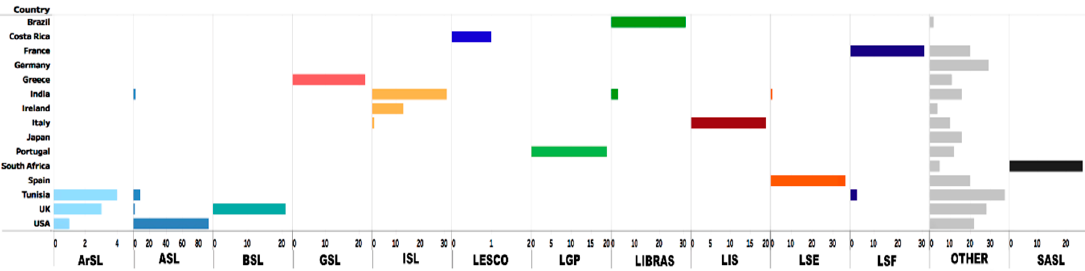
Figure 9. Project/SL and country chart.